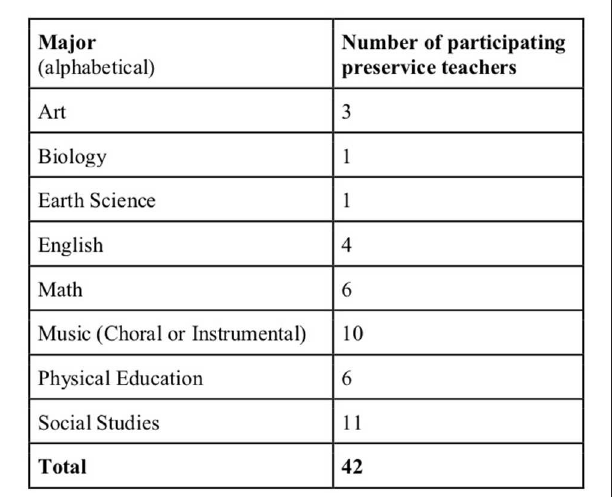
FIGURE 1 | Participating preservice teachers’